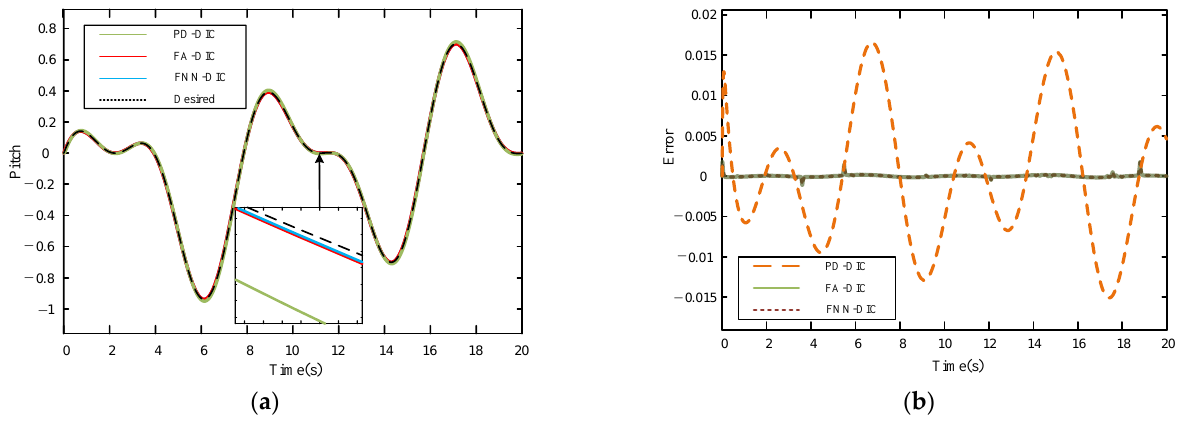
Figure 9. The results of the pitch angle trajectory tracking. ( a ) Pitch angle tracking track, and ( b ) pitch angle tracking error.